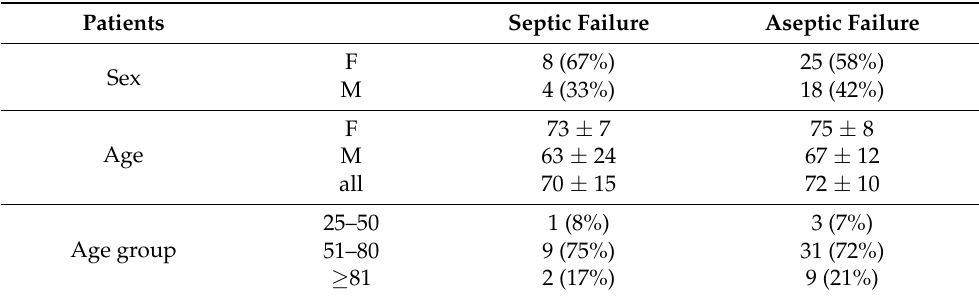
Table 1. Demographic information of analyzed subjects and their distribution per year. The per- centage reported refers to the number of cases per year. Data referring to patients’ age are reported as mean ± standard deviation.